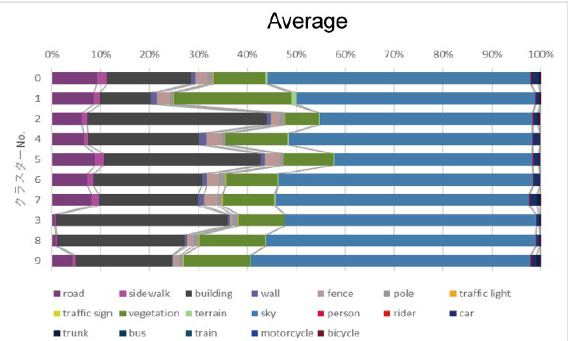
Figure 7. Comparison of street component distributions among clusters based on semantic